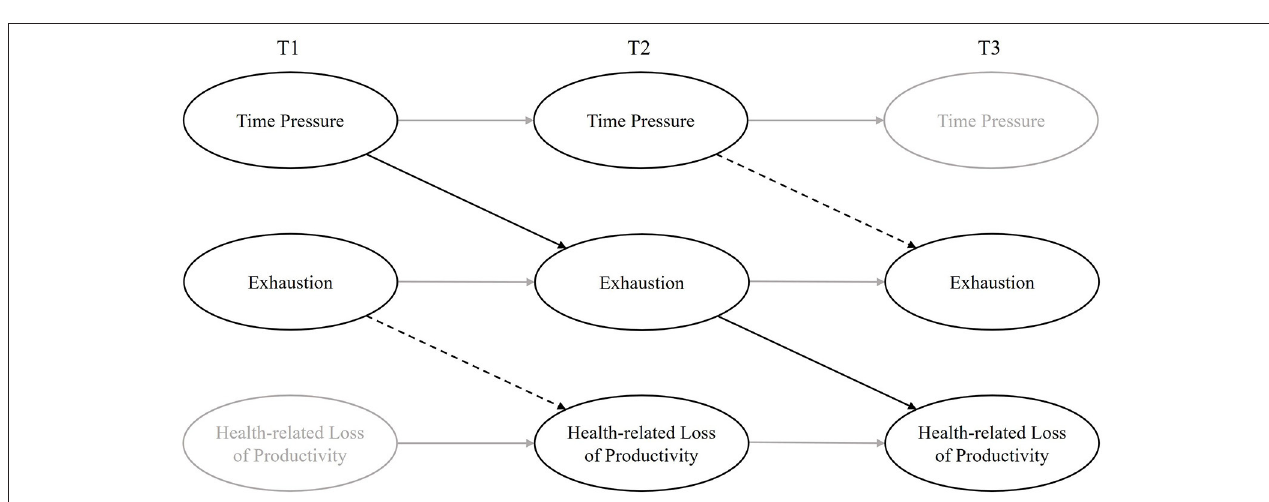
FIGURE 2 | The hypothesized model. All exogenous latent constructs are represented by manifest variables shown in Table 2 .